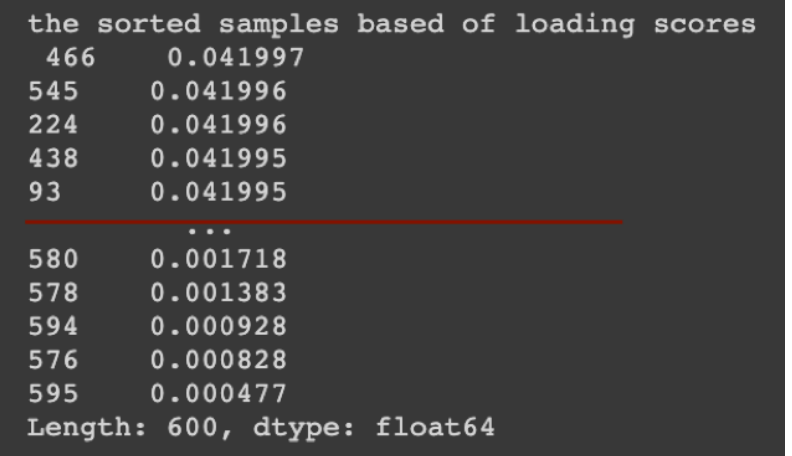
Figure 17. Threshold cutoff limit of the breast cancer classification dataset.